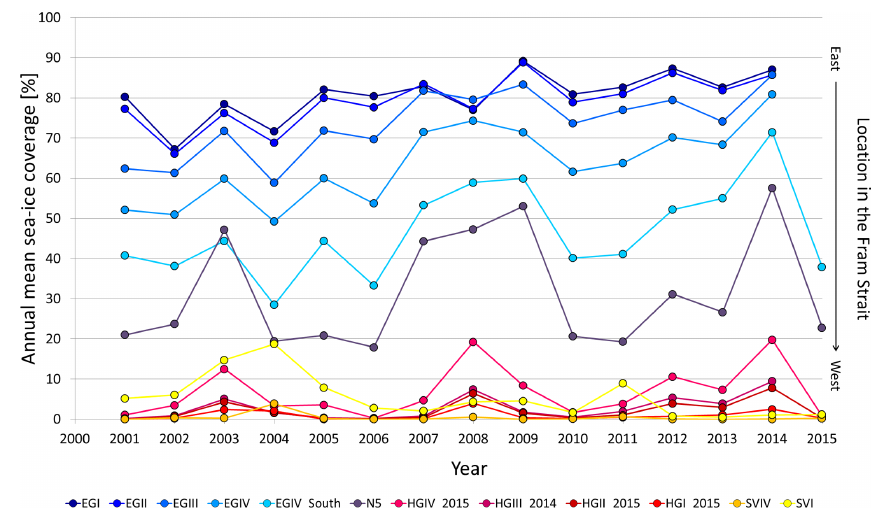
Figure 2. Annual mean sea-ice concentrations from 2001 to 2015 of a subset of sampled stations. The sampling year at the HG stations (central HAUSGARTEN stations; Soltwedel et al., 2005) is given, as HG stations were sampled in 2014 and 2015 and therefore the given sampling year refers to the exact position from which the sea-ice data were